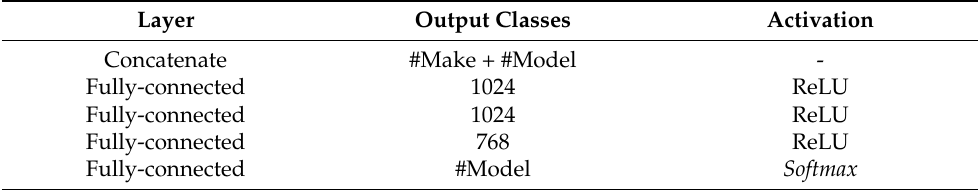
Table 1. Layer configuration of Decision Module.